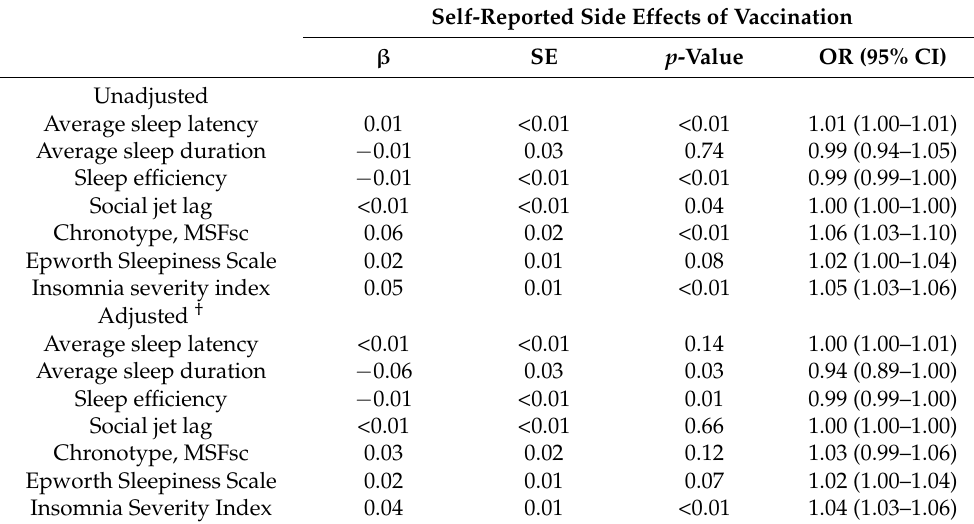
Table 6. Association of sleep pattern with self-reported side effects of COVID-19 vaccination. Self-Reported Side Effects of